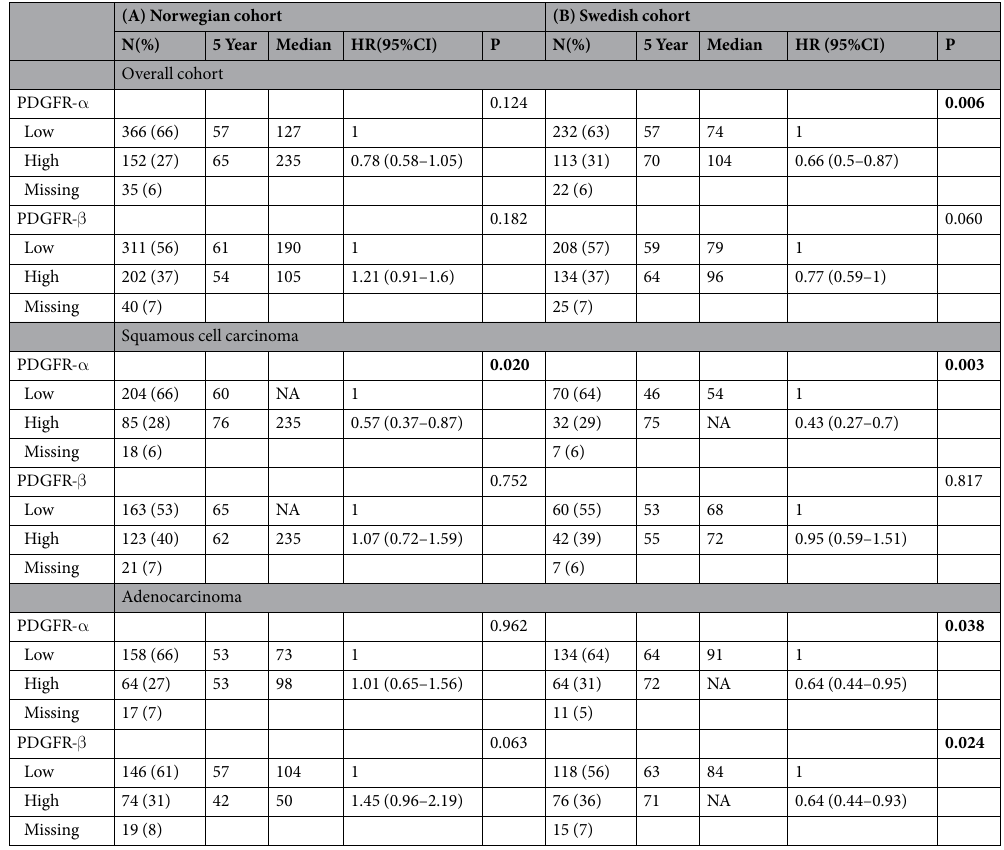
Table 3. PDGFR- α , PDGFR- β as predictors of (A) disease-specific survival in a Norwegian cohort of 553 stage I-IIIB NSCLC patients (307 and 239 in the SCC and ADC subgroups respectively) and (B) overall survival in a Swedish cohort of 367 stage I NSCLC patients (109 and 209 in SCC and ADC subgroups respectively,